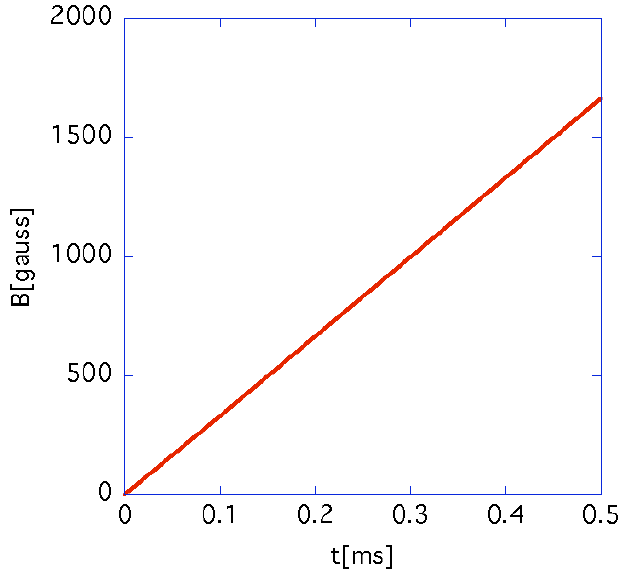
FIG. 10. (Color) The magnetic field is excited during 0.5 ms and its flux density at x ¼ y ¼ 0 to have become 1664 G (analytical